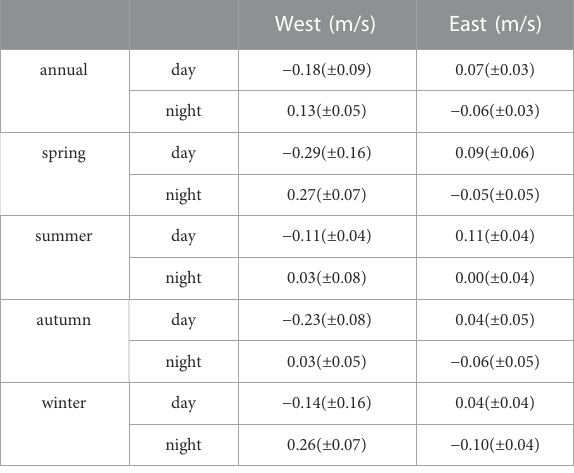
TABLE1Themeanoflocaldeviatedwind Δ u inthewestandeastsideofthe Yangtze River (negative value indicates easterly wind; positive value indicates westerly